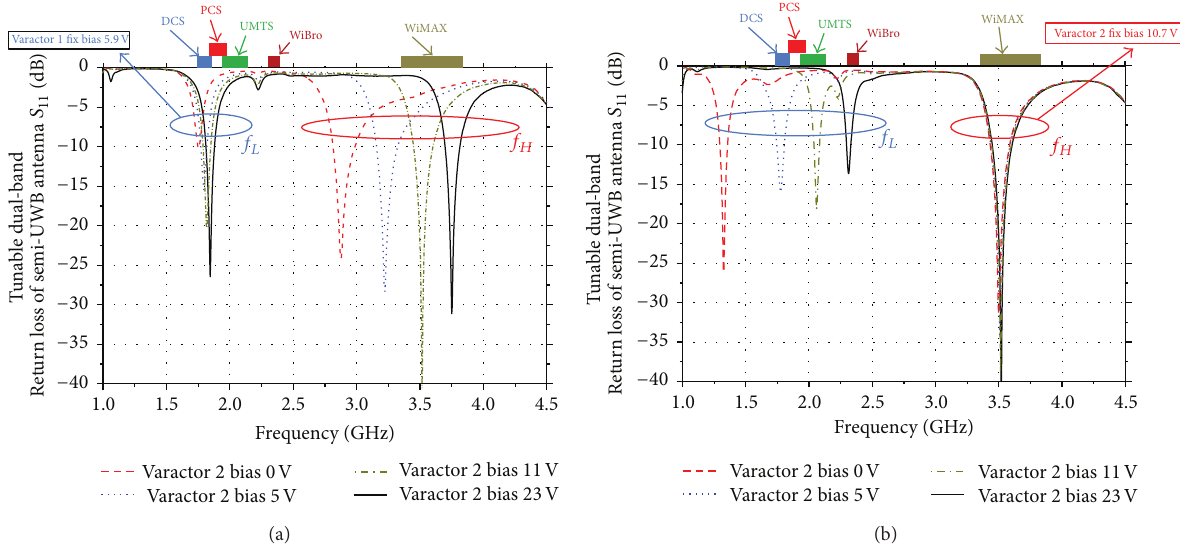
Figure 8: Measurement result of continuous tunable dual-band antenna: (a) independent tunable 𝑓 𝐻 ; (b) independent tunable 𝑓 𝐿 .